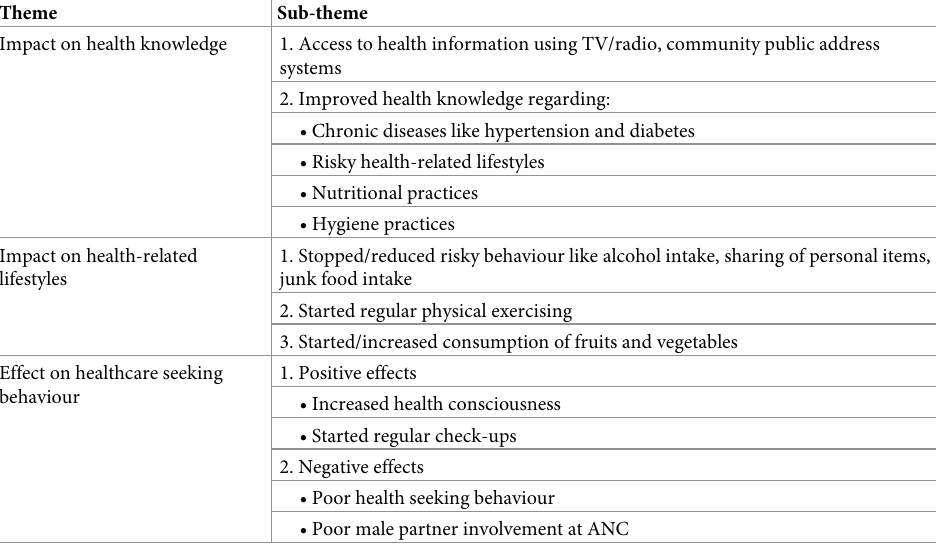
Table 1. Themes on the impact of COVID-19 pandemic on health knowledge and care seeking